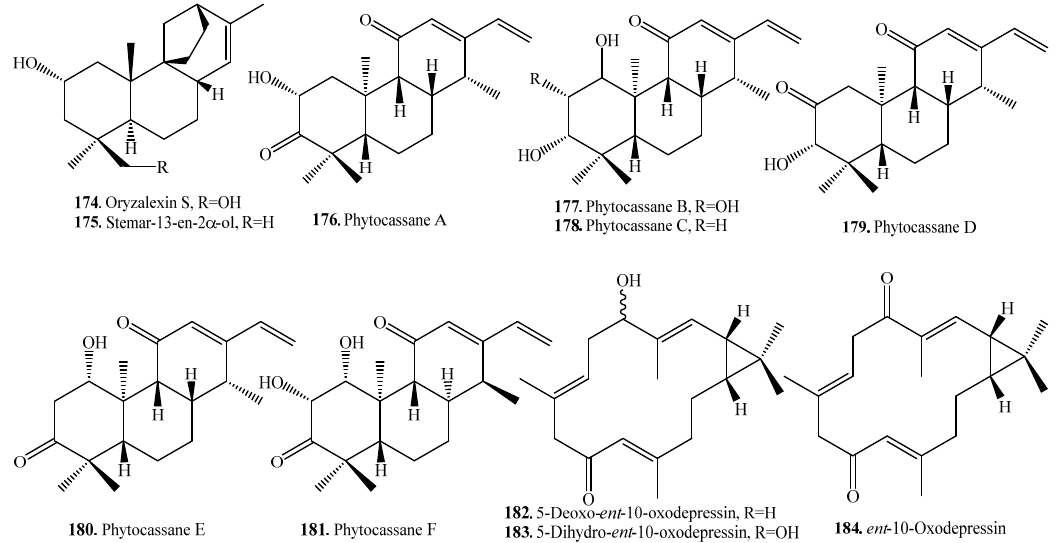
Figure 5. Structures of the diterpenoids isolated from rice.